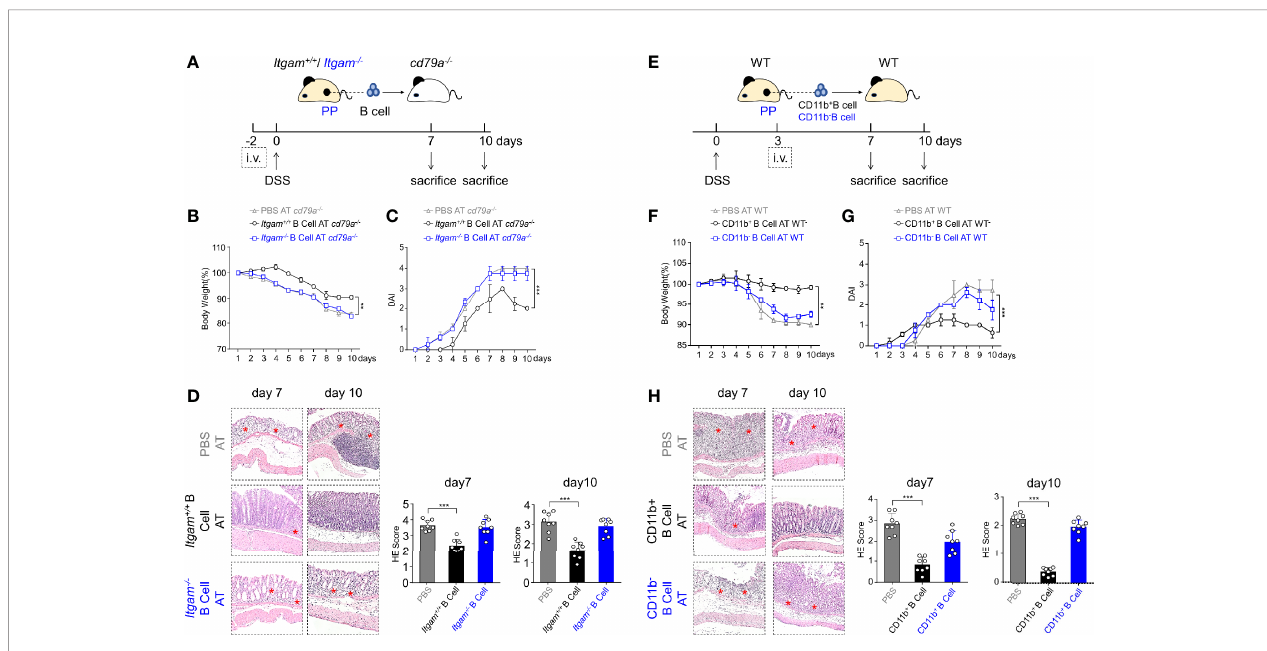
FIGURE 2 | CD11b-de fi cient B cells exhibit impaired ability to resolve colitis. (A) Each Cd79a − / − mouse intravenously received 1 × 10 7 PP-derived B cells from WT mice ( Itgam +/+ ) or Itgam − / − mice 2 days before the induction of colitis. Mice were evaluated daily, and weight loss (B) and disease activity index (DAI) scores (C) were recorded. (D) Representative distal colon histological sections of Cd79a − / − mice were stained with hematoxylin and eosin (H&E), and the histological score was calculated. Images are displayed at the original magni fi cation of ×100. Red stars indicate the position of the in fl ammatory cell in fi ltration and/or epithelial damage. (E) PP-derived B cells of WT mice were sorted and stimulated with lipopolysaccharide (LPS) for 48 h in vitro . CD11b + and CD11b − B cells were subsequently puri fi ed and intravenously injected (5 × 10 6 cells per mice) into WT mice treated with DSS for 3 days. Weight loss (F) and the DAI scores (G) of recipient mice were measured and evaluated from day 0 to day 7. (H) H&E-stained histological sections of distal colon tissue are presented. Images are displayed at the original magni fi cation of ×100. Red stars indicate the position of the histological injury. **P < 0.01, ***P < 0.001. Data are expressed as mean ± SEM of eight